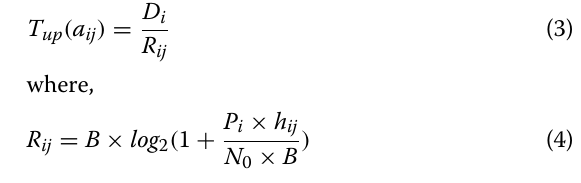
cluster manager that is in vicinity of the mobile end-user. It should be noted that the mobility of end-user is not considered in the rest of the